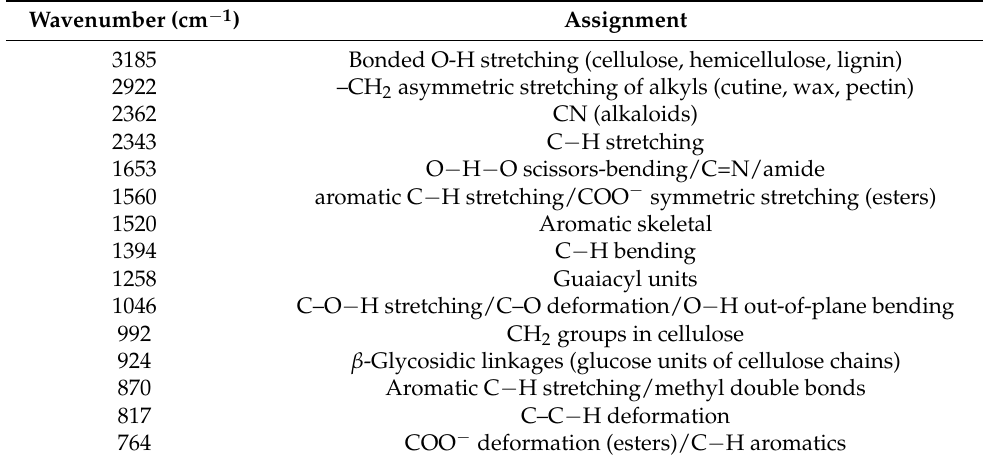
Table 1. Main absorption bands in the infrared spectrum of U. tomentosa